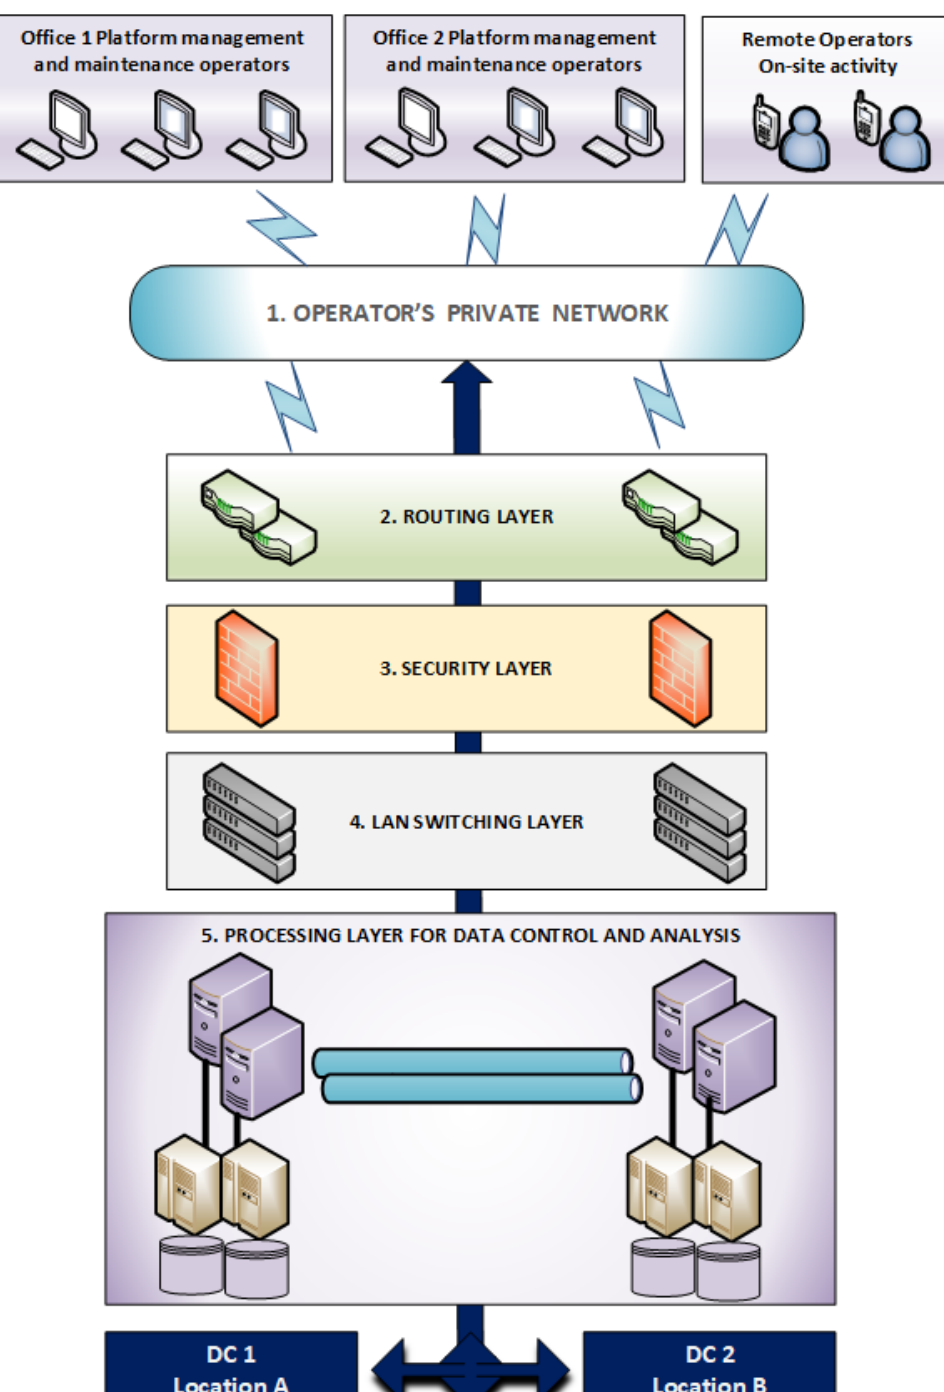
Figure 1. Computing core group